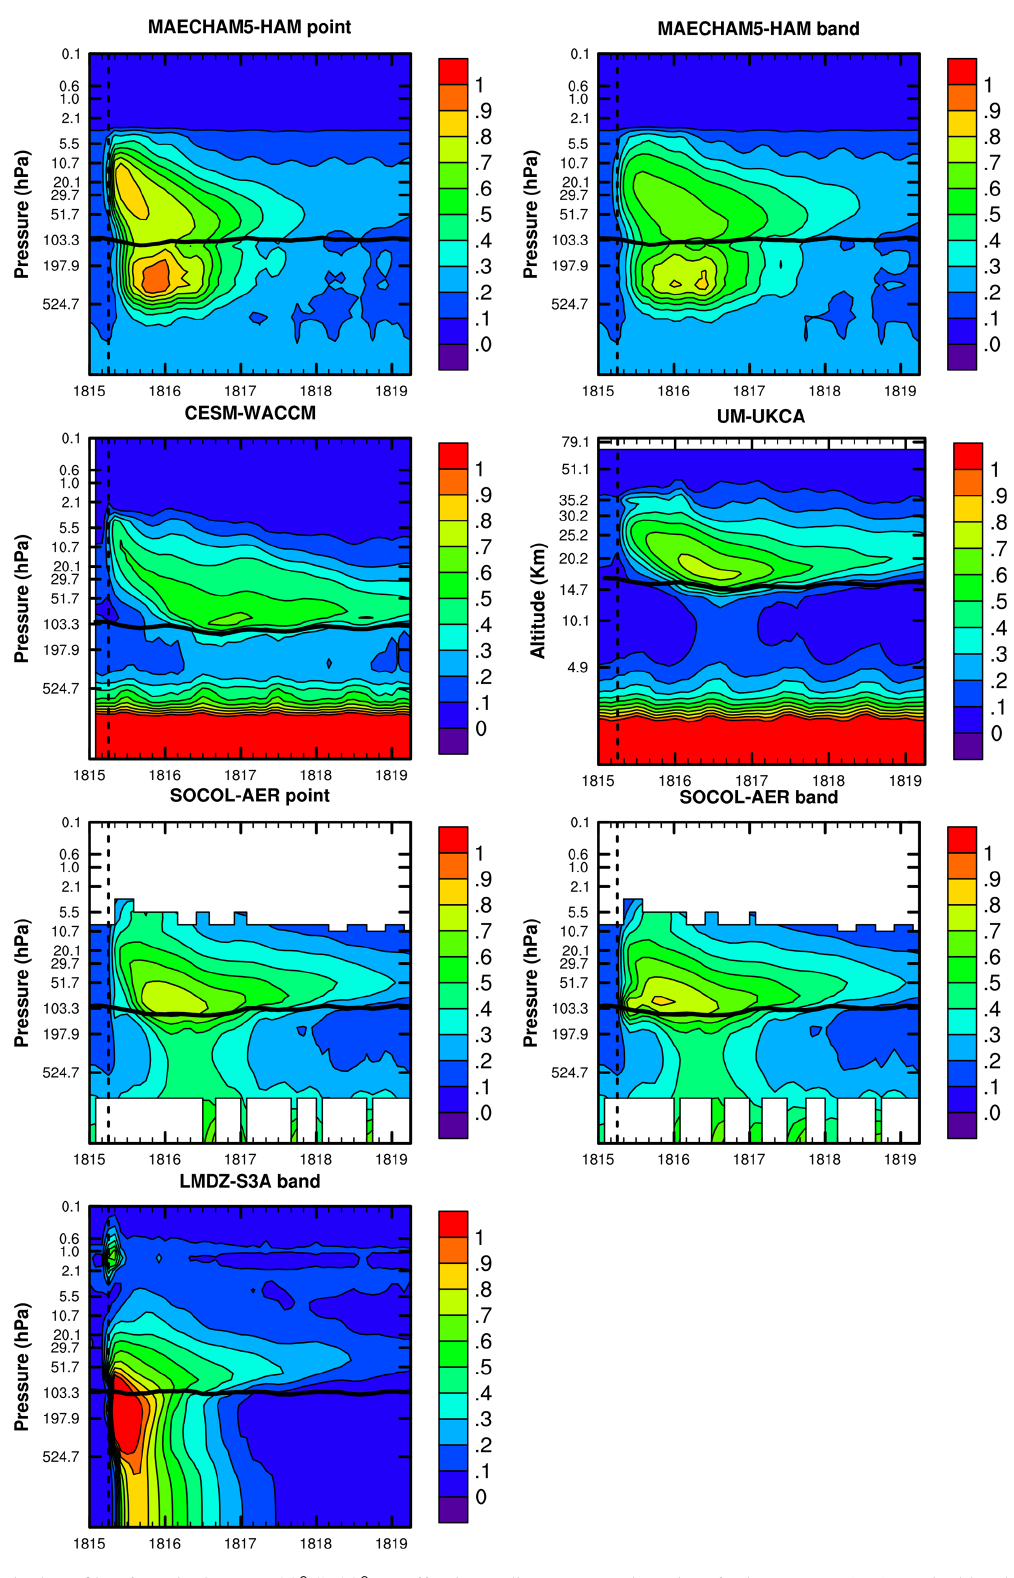
Figure 4. Vertical profile of tropical mean [23 ◦ S, 23 ◦ N] effective radius contours in units of micrometers (µm) marked by the color bar. A vertical dashed line marks the April 1815 injection. A horizontal solid black line marks tropopause height. The large particles in the lower troposphere in this figure (CESM-WACCM and UM-UKCA) are due to background particles such as sea spray and dust. Atmos. Chem. Phys., 21, 3317–3343, 2021